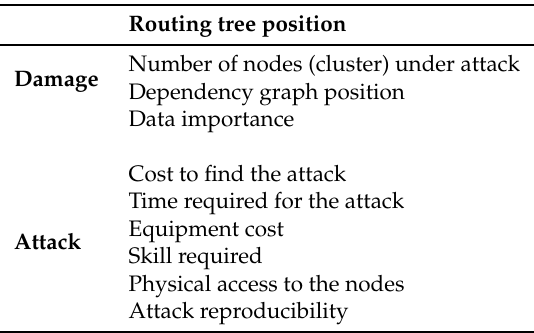
Table 2. Damage and attack